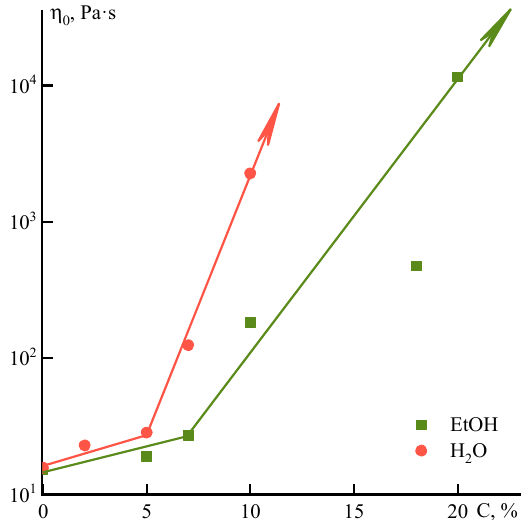
Figure 13. Dependence of the Newtonian viscosity on the concentration of ethanol and water introduced into the solution.